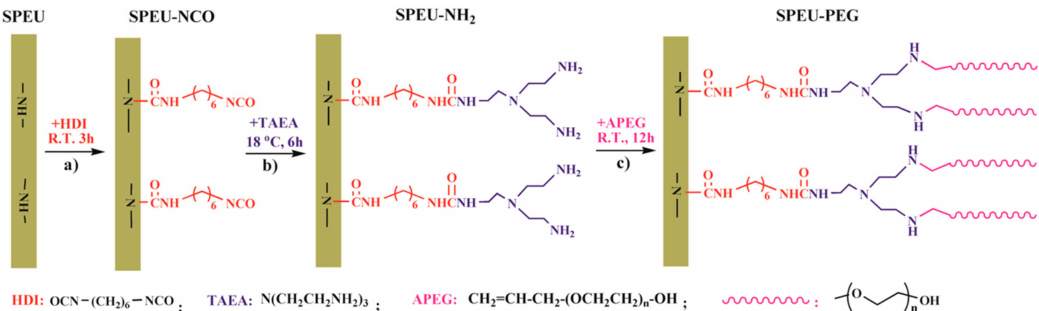
Figure 1. Schematic diagram of grafting PEG onto SPEU surface via ( a ) allophanate reaction; ( b ) condensation reaction; and ( c ) Michael addition